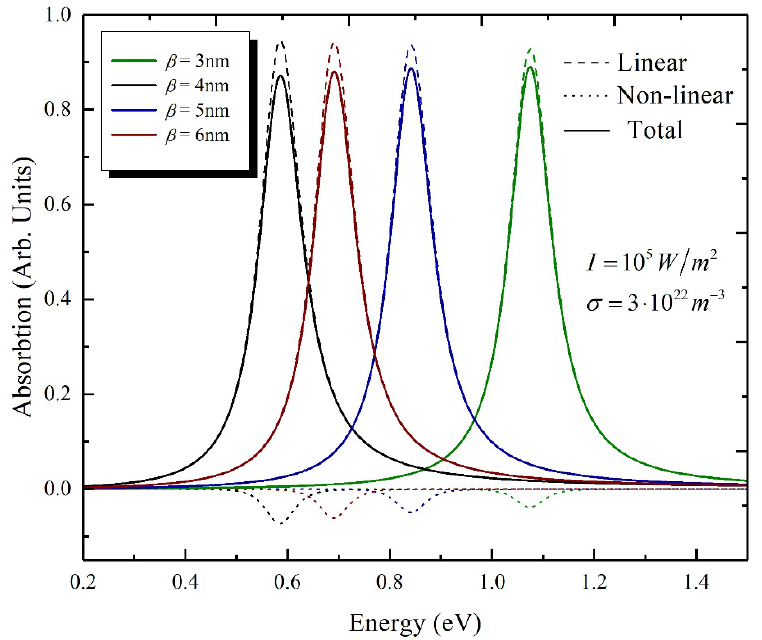
Figure 4. Dependence of the linear, non-linear and total absorption coefficient on the energy of the incident light for four different values of β .